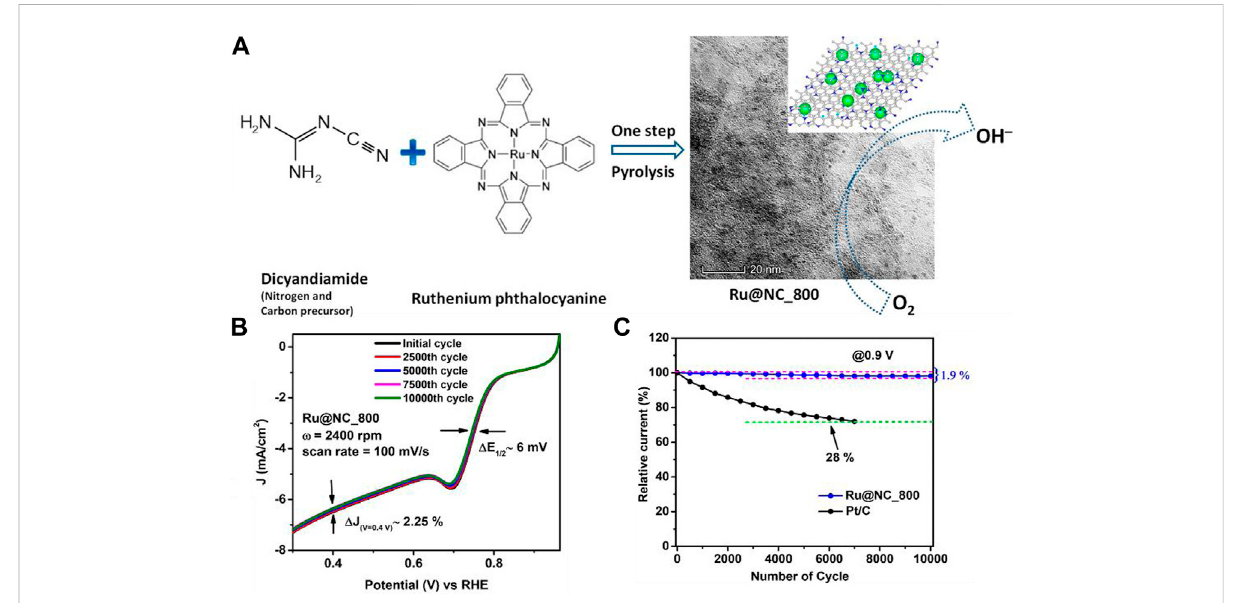
FIGURE 9 (A) Illustration of the synthesis route; (B) activity of the as-synthesized catalyst for different cycles of tests; and (C) the stability comparison of Ru@NC_800 and commercial Pt/C. Reproduced with permission (Bisen and Nanda, 2021). Copyright 2021, American Chemical